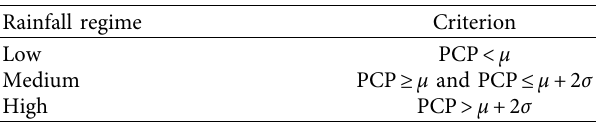
Table 2: Partition of overall precipitation time series into low, medium, and high precipitation values (PCP is precipitation, μ is mean of precipitation, and σ is the standard deviation of